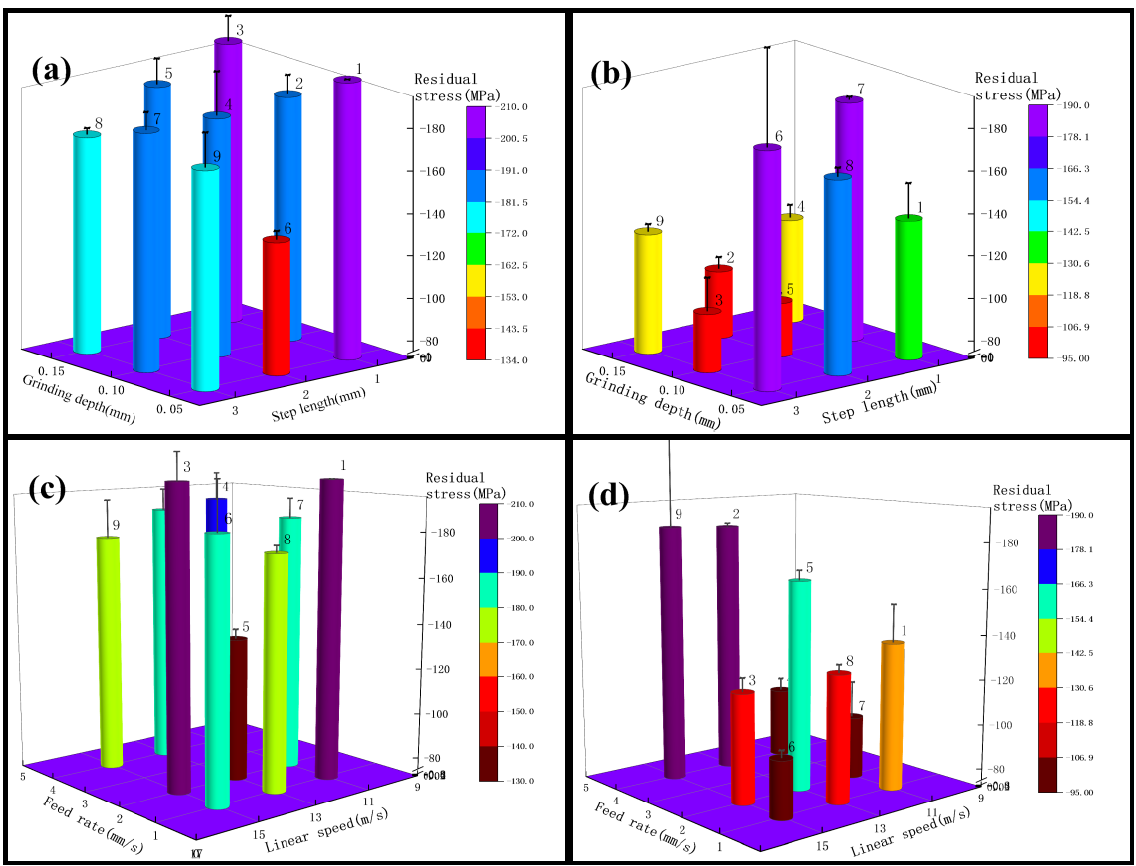
Figure 7. ( a ) for test 2, variables are grinding depth and step length, ( b ) for test 4, variables are grinding depth and step length; ( c ) for test 2, variables are linear speed and feed rate, ( d ) for test 4, variables linear speed and feed rate.